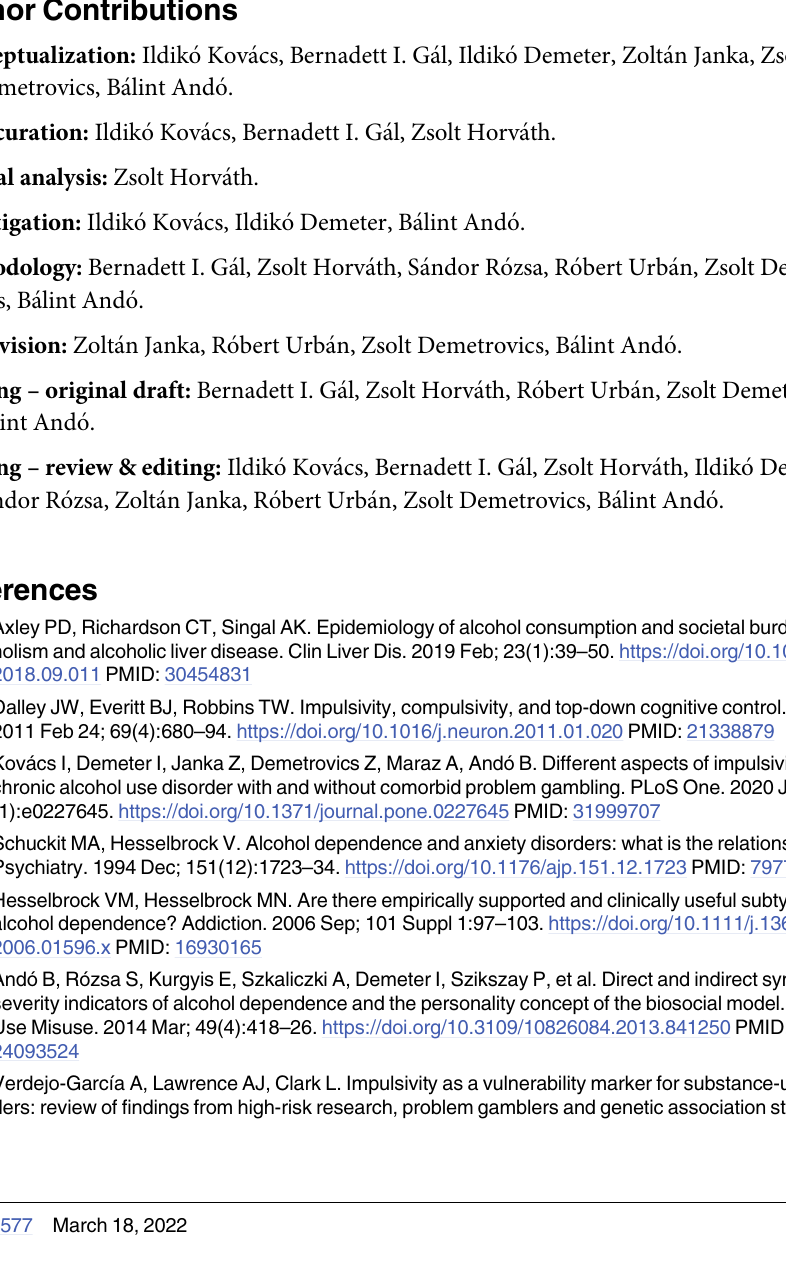
S2 Table. Model fit indices of the different latent classes (N = 99). Note. AIC = Akaike Information Criteria; BIC = Bayesian Information Criteria; SSA-BIC = Sample size